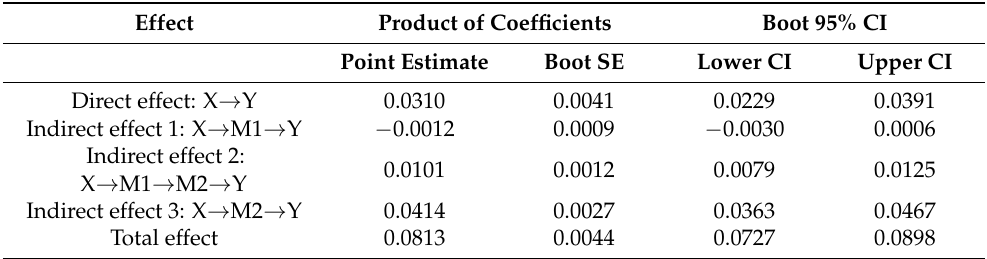
Table 6. Mediating effects in the mediation model.